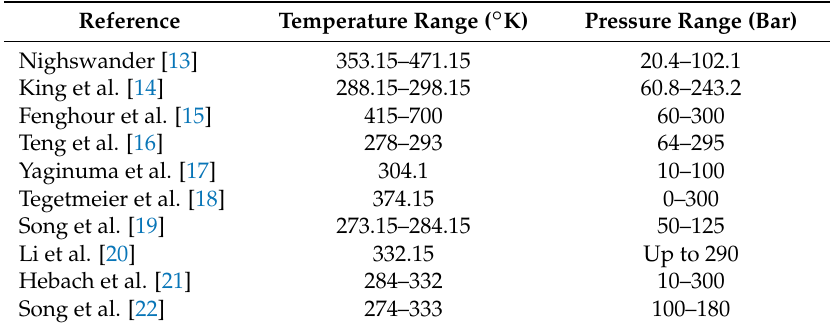
Table 1. Experimental studies to measure density of the CO 2 –CaCl 2 –H 2 O